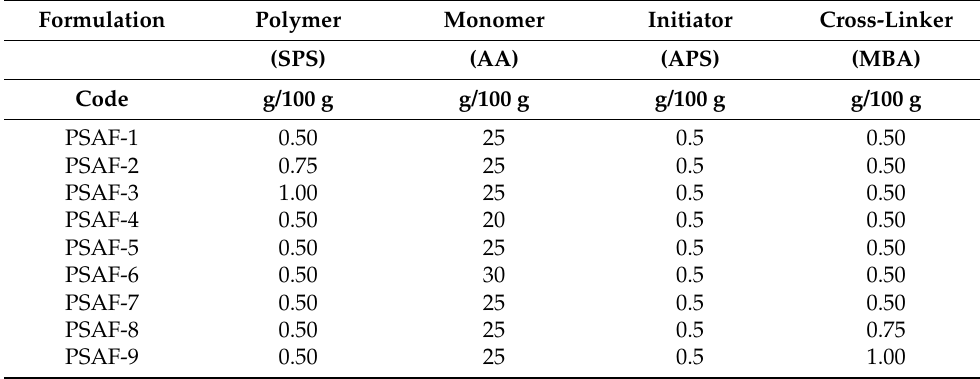
Table 3. Chemical composition of SPSPAA